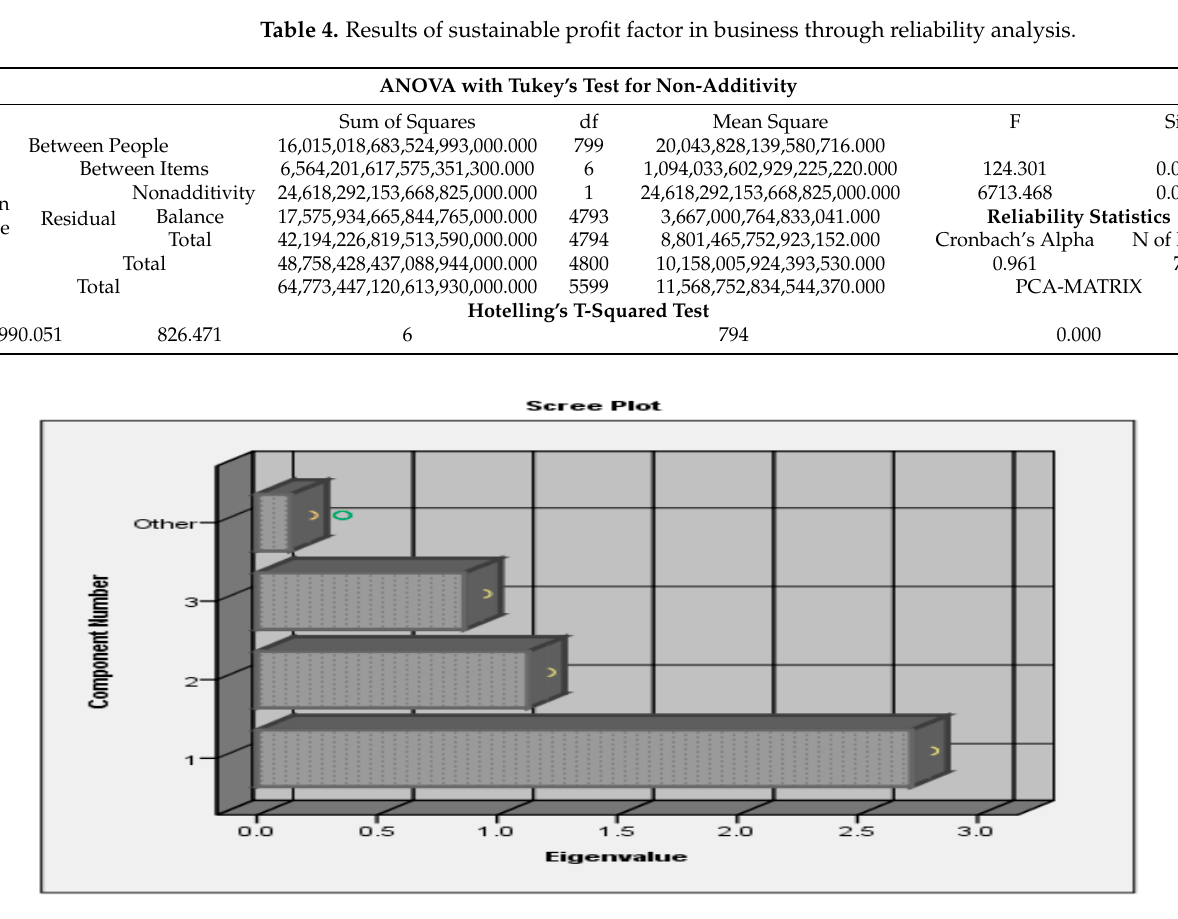
Table 4. Results of sustainable profit factor in business through reliability analysis.